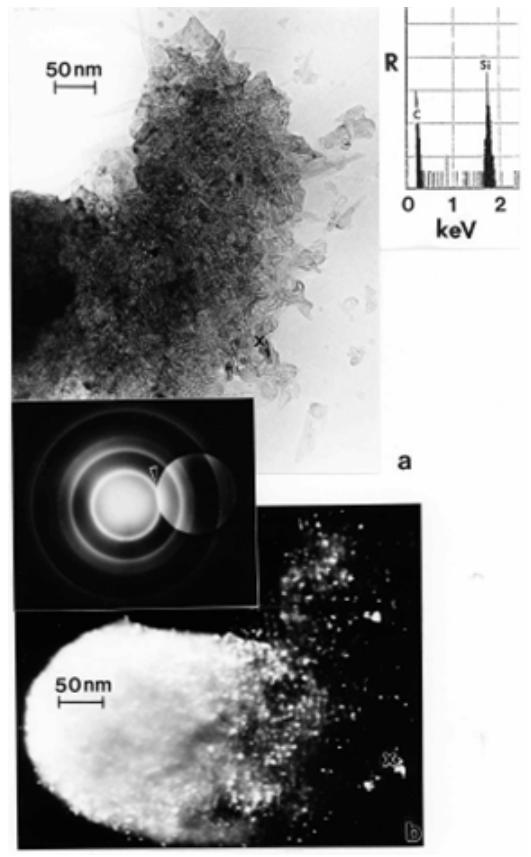
Figure 5: Complex aggregate composed of a mixture of carbon nanotube and related carbon nanoparticles and ) nanocrystal particles. (a) Bright-field TEM silica (SiO 2 image with corresponding EDS spectrum showing C (K α ) and Si (K α ) peaks. The oxygen peak is suppressed in the X-ray emission competition. (b) Dark-field TEM image slightly shifted from (a) showing predominantly strongly diffracting nanocrystals (reference X). The SiO 2 principal diffraction regimes marked 1 and 2 in the SAED pattern insert are characterized by overlapping /(101)SiO and (100) /(200)SiO diffraction, (002) C 2 C 2 respectively [26].